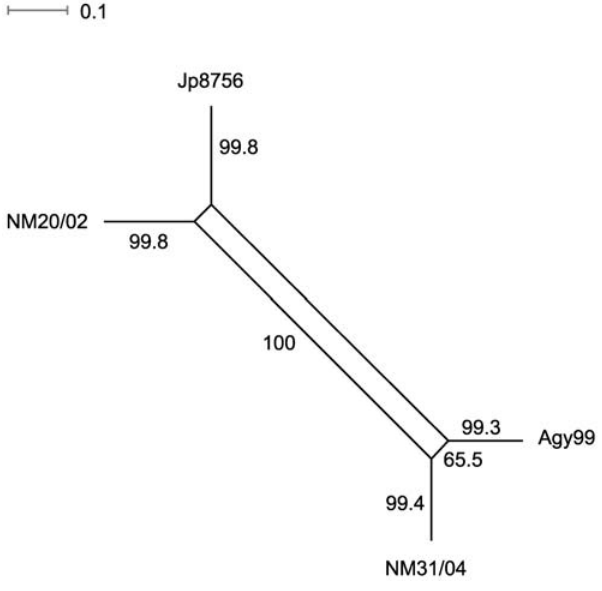
Figure 5. NeighborNet network of the M.ulcerans strains based on the parsimony informative SNPs. Bootstrap values shown close to branches are based on 1000 bootstrap replicates.